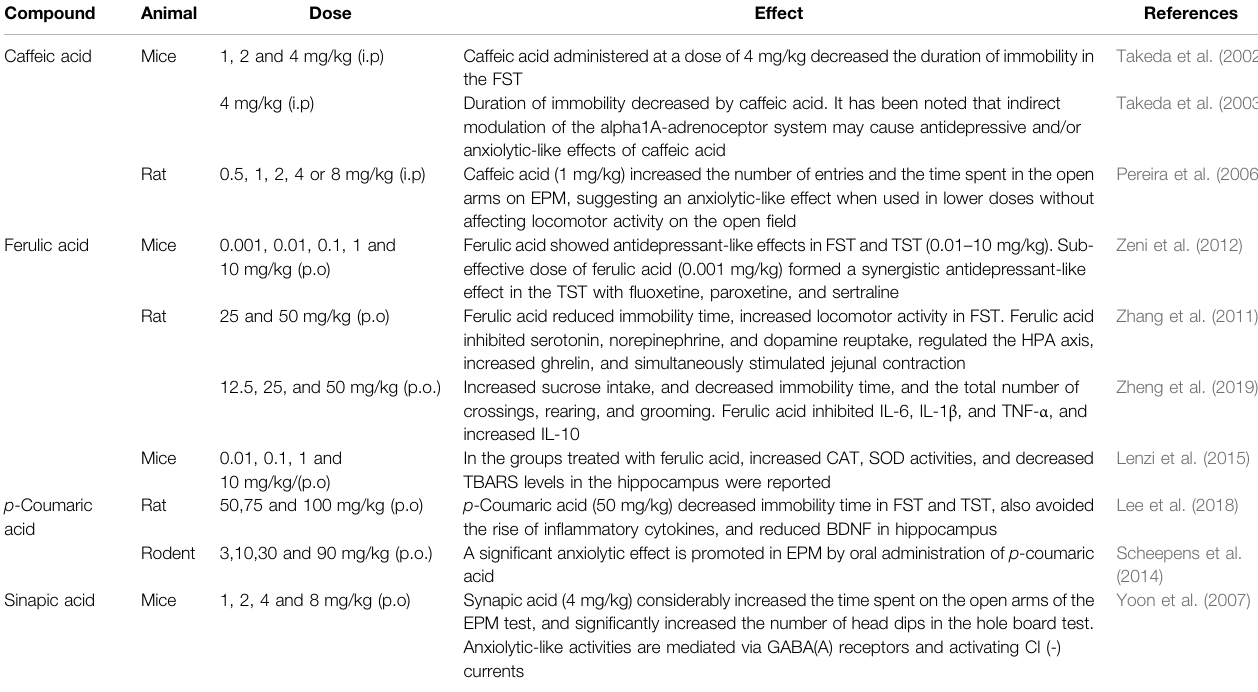
TABLE 3 | The antidepressant and anxiolytic effects of cinnamic acids. Compound